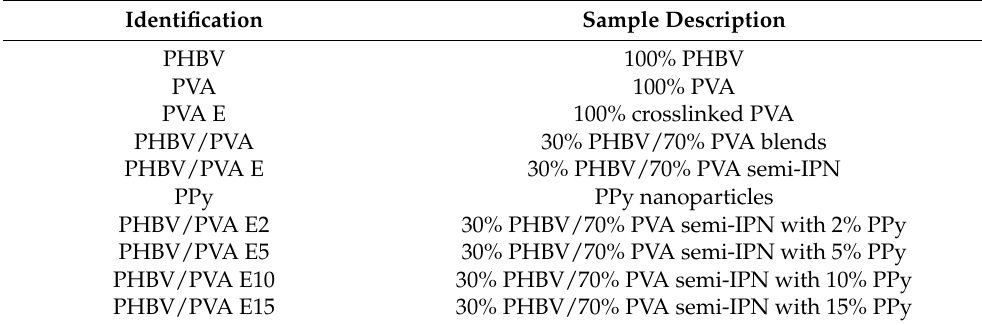
Table 1. Sample notation for the films based on poly(3-hydroxybutirate-co-3-hydroxyvalerate) (PHBV), poly (vinyl alcohol) (PVA) and polypirrole (PPy). Identification Sample